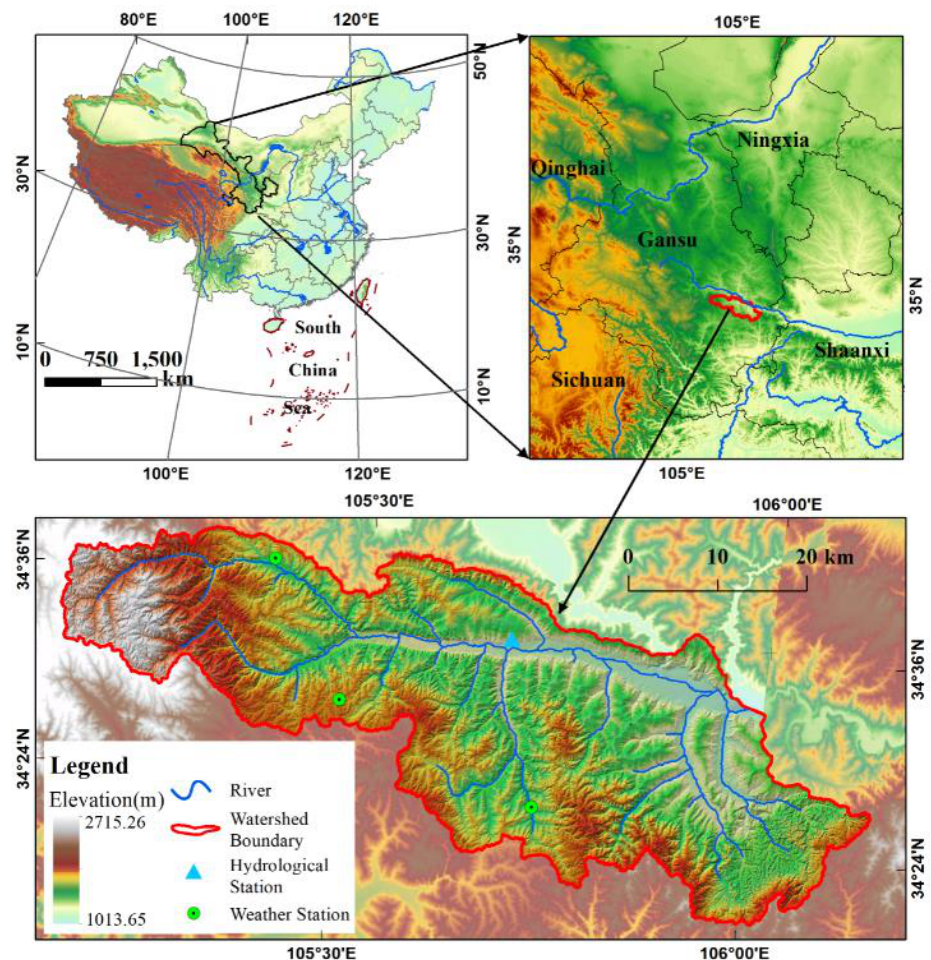
Figure 1. The location and Digital Elevation Model (DEM) of the Xihe River Basin.